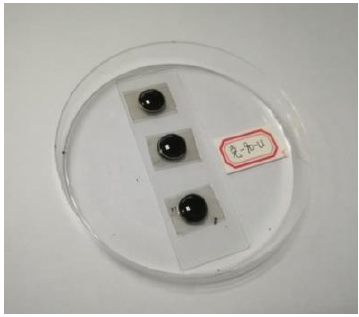
Figure 1. Asphalt samples.